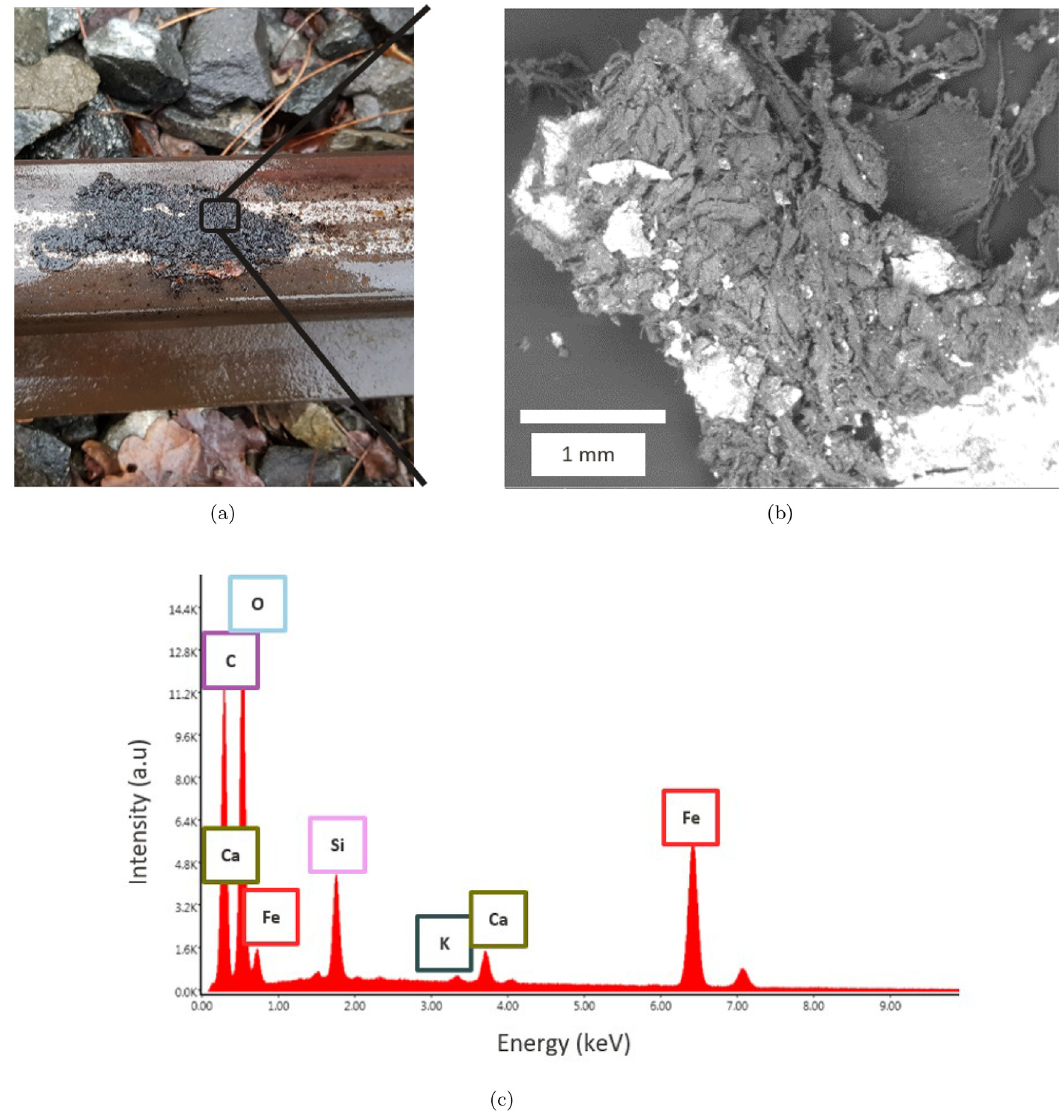
Fig. 6. (a) Macroscopic image of an on-site third body responsible for adhesion losses. (b) SEM image of the sample (BSE detector), (c) EDS spectrum of the sample observed (b). The elements found correspond to plant